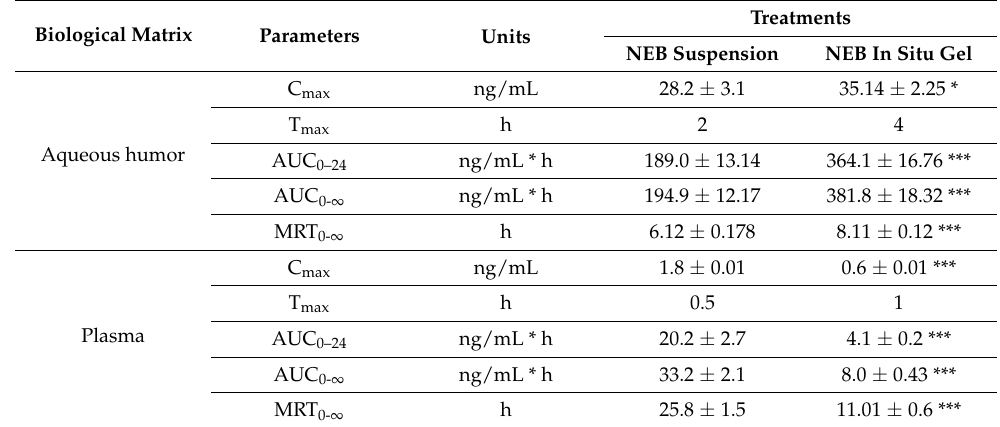
Table 5. Pharmacokinetic parameters of NEB in aqueous humor and plasma following ocular administration of an NEB suspension and optimized NEB-loaded dual-responsive in situ gel in male New Zealand white